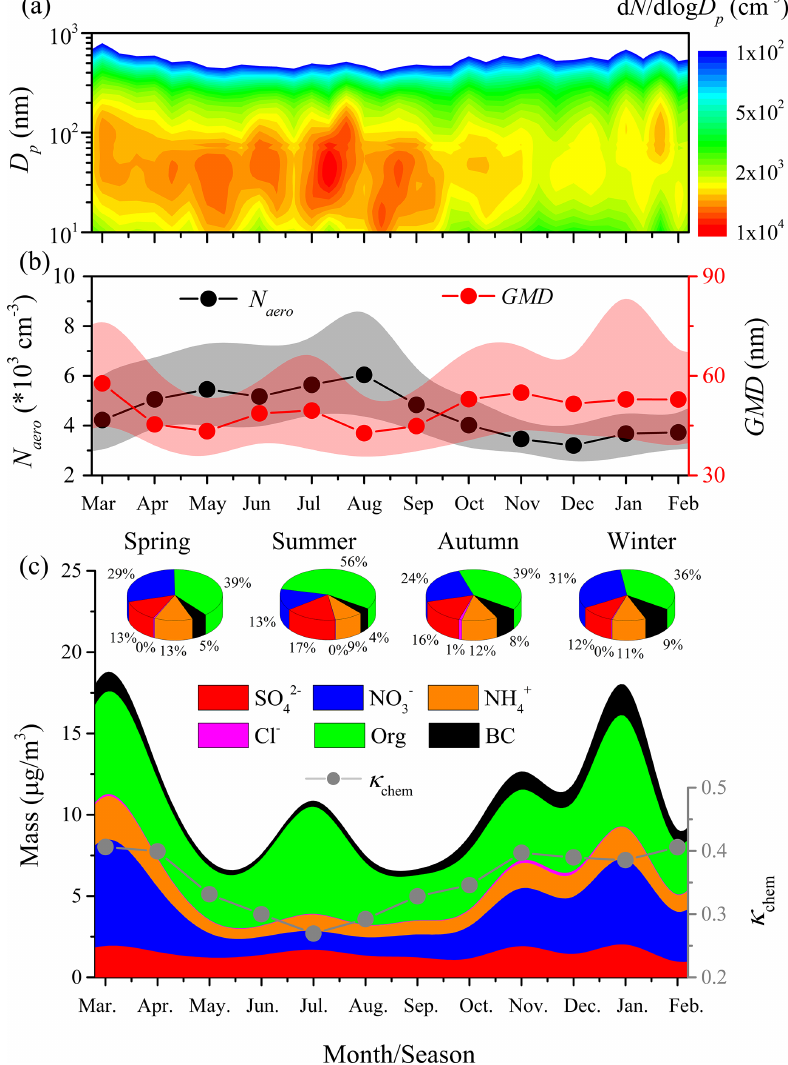
Figure 4. Seasonal variations of (a) aerosol particle number size distribution (d N aero /dlog D p vs. D p , where D p is particle diameter), (b) total aerosol number concentration with a D p range of 10 to 800nm ( N aero ) and geometric mean diameter of the particles (GMD), and (c) mass concentration and ratio of each component in aerosol particle with D p less than 1µm and the hygroscopicity factor calculated from the chemical composition ( κ chem ). Dots represent the median values. Shaded areas represent the values in the range from the 25th to 75th